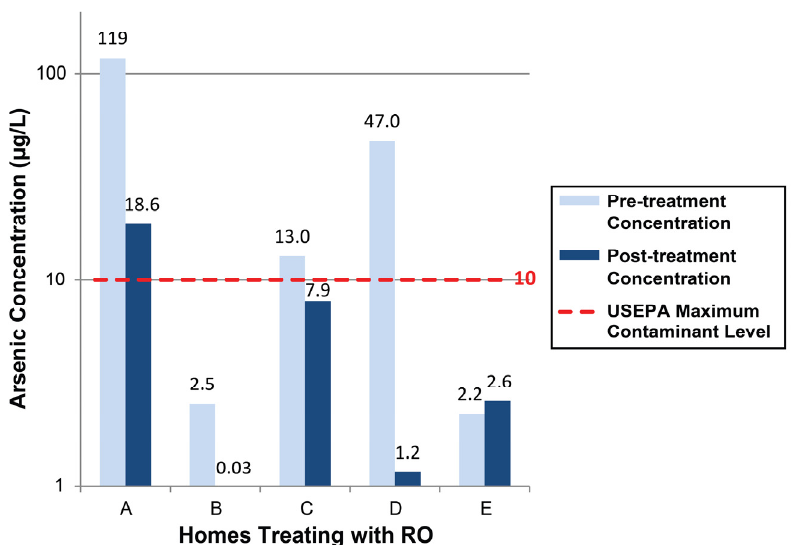
Figure 2. Arsenic concentrations in water samples before home treatment (Pre-treatment Concentration) and after RO treatment (Post-treatment Concentration) from homes with paired